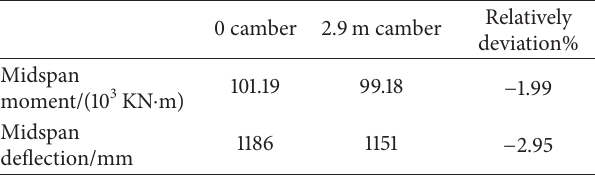
− 11700 − 1.0 pylon Pylon 36150 27.2 The moment of pylon takes place at the root. The displacement of pylon takes place at top and the positive direction points to midspan. The positive direction of girder displacement points to upward side. Table 3: Effect of camber of main